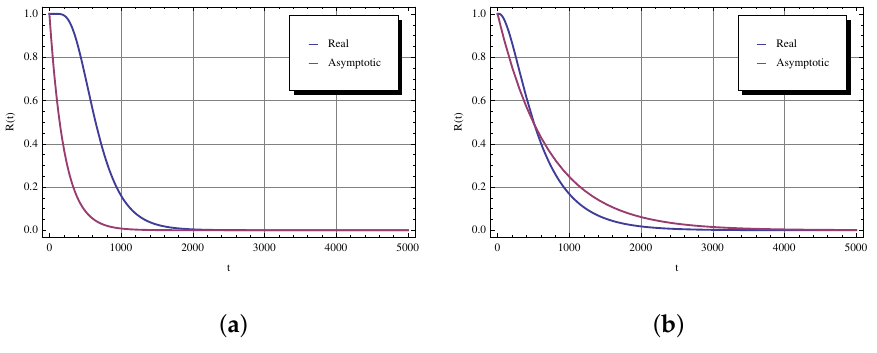
Figure 10. Real and asymptotic reliability functions R ( t ) for ν = 0.05 ( a ) and ν = 0.10 ( b